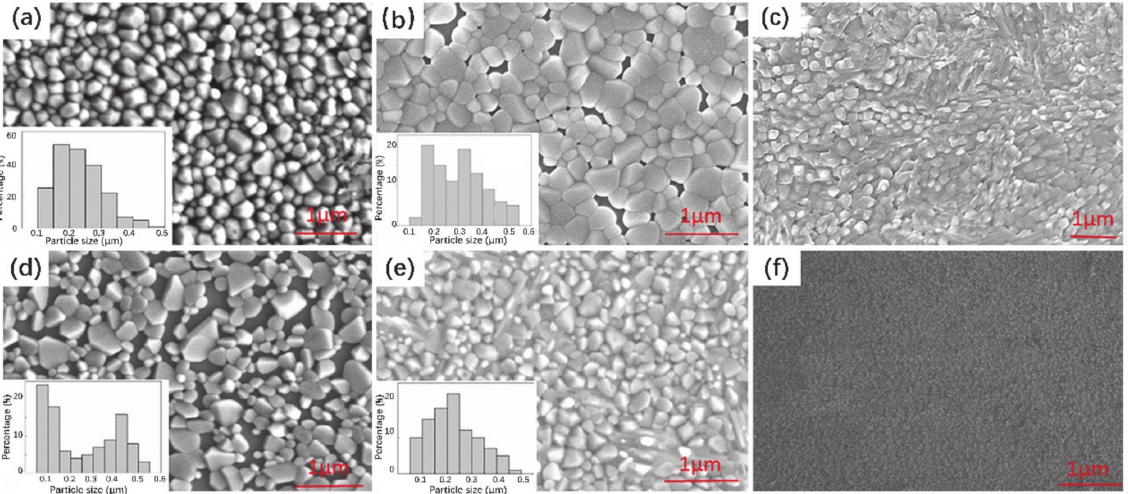
Figure 16. SEM images of VO 2 thin films with different oxidation conditions: ( a ) 400 ◦ C, 2 sccm, ( b ) 425 ◦ C, 2 sccm, ( c ) 410 ◦ C, 2 sccm, ( d ) 425 ◦ C, 1 sccm, ( e ) 425 ◦ C, 5 sccm and ( f ) 390 ◦ C, 2 sccm. Reproduced from [121], with permission from AIP Publishing,